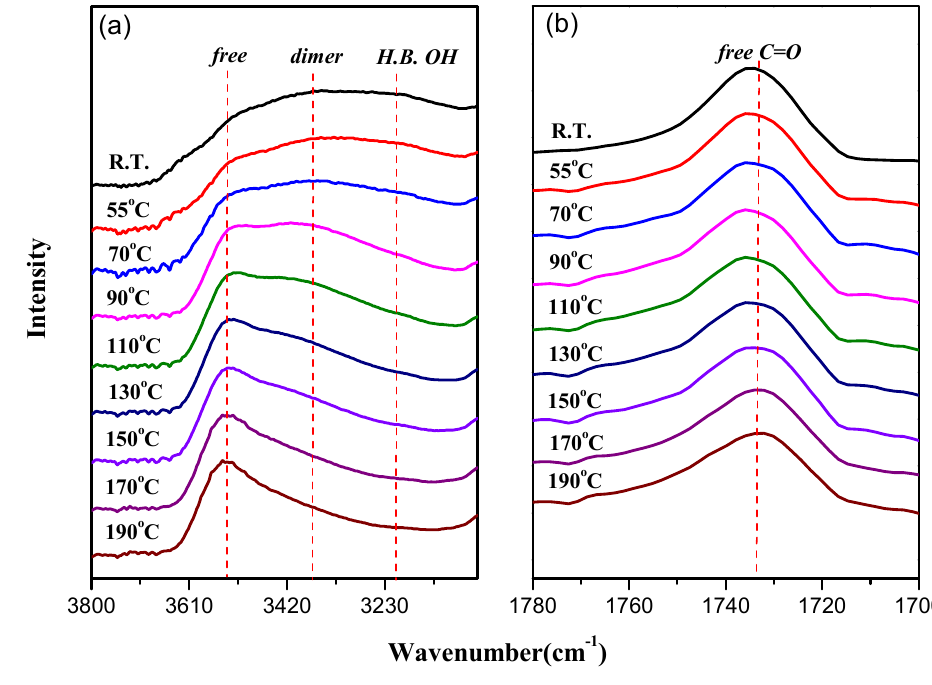
Figure 12. FTIR spectra of phenolic/PMA-POSS = 60/40, recorded at various temperatures: ( a ) OH stretching and ( b ) C=O stretching